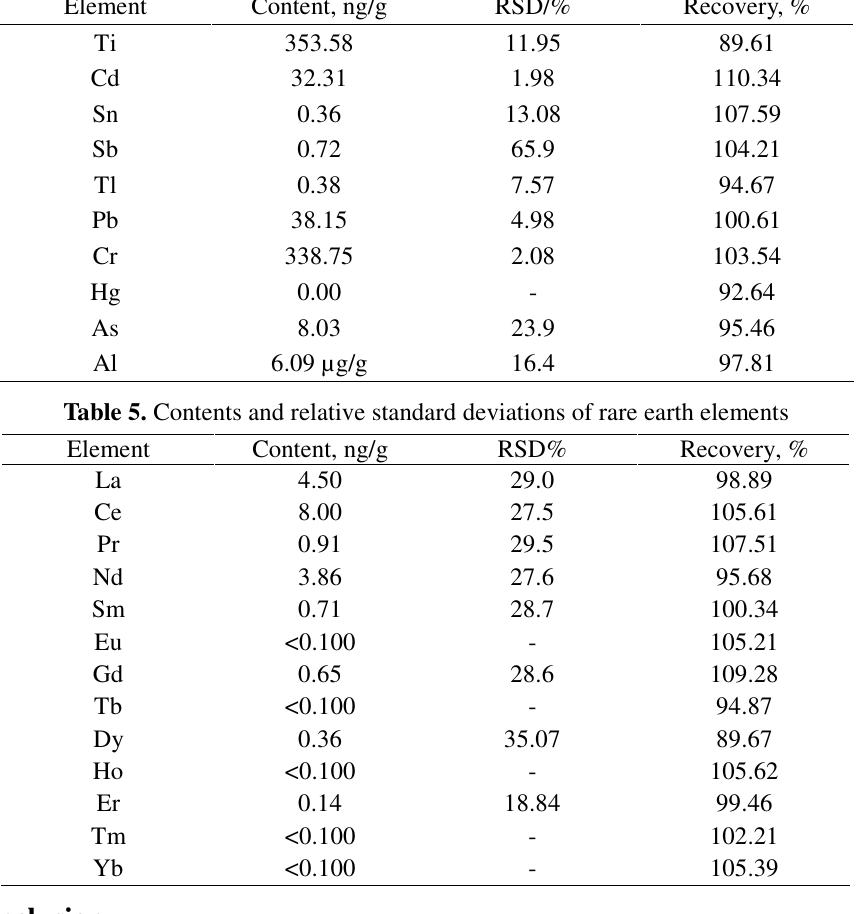
Table 4. Contents and relative standard deviations of toxic elements